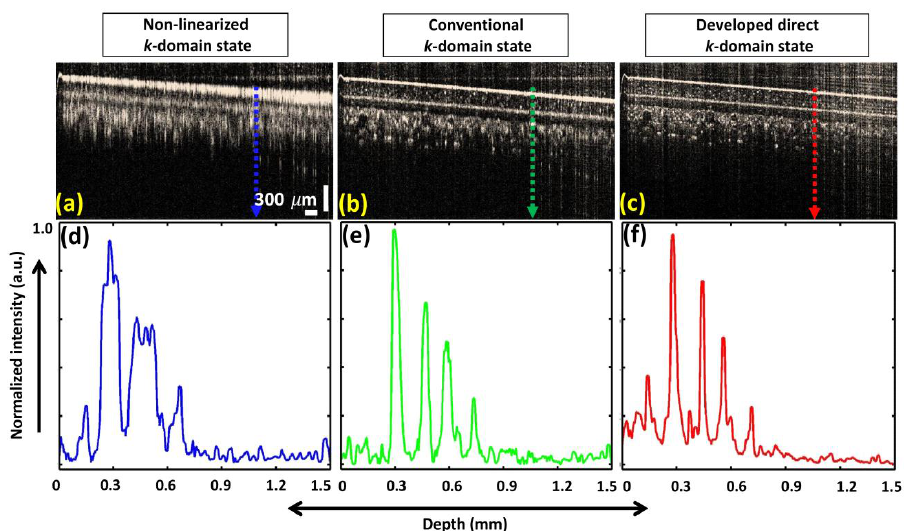
Figure 5. Cross-sectional and quantitative representations of infrared detection card at non-linearized k -domain state ( a , d ), conventional k -domain linearization state ( b , e ), and proposed direct k -domain state ( c , f ).